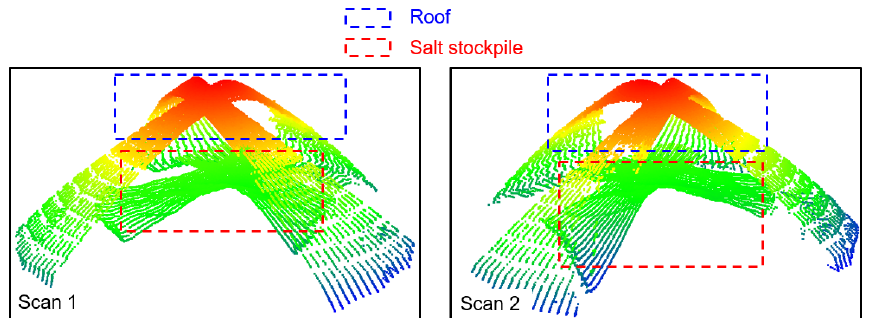
Figure 10. Examples of two successive scans colored by height (for easier illustration, the ground has been removed).